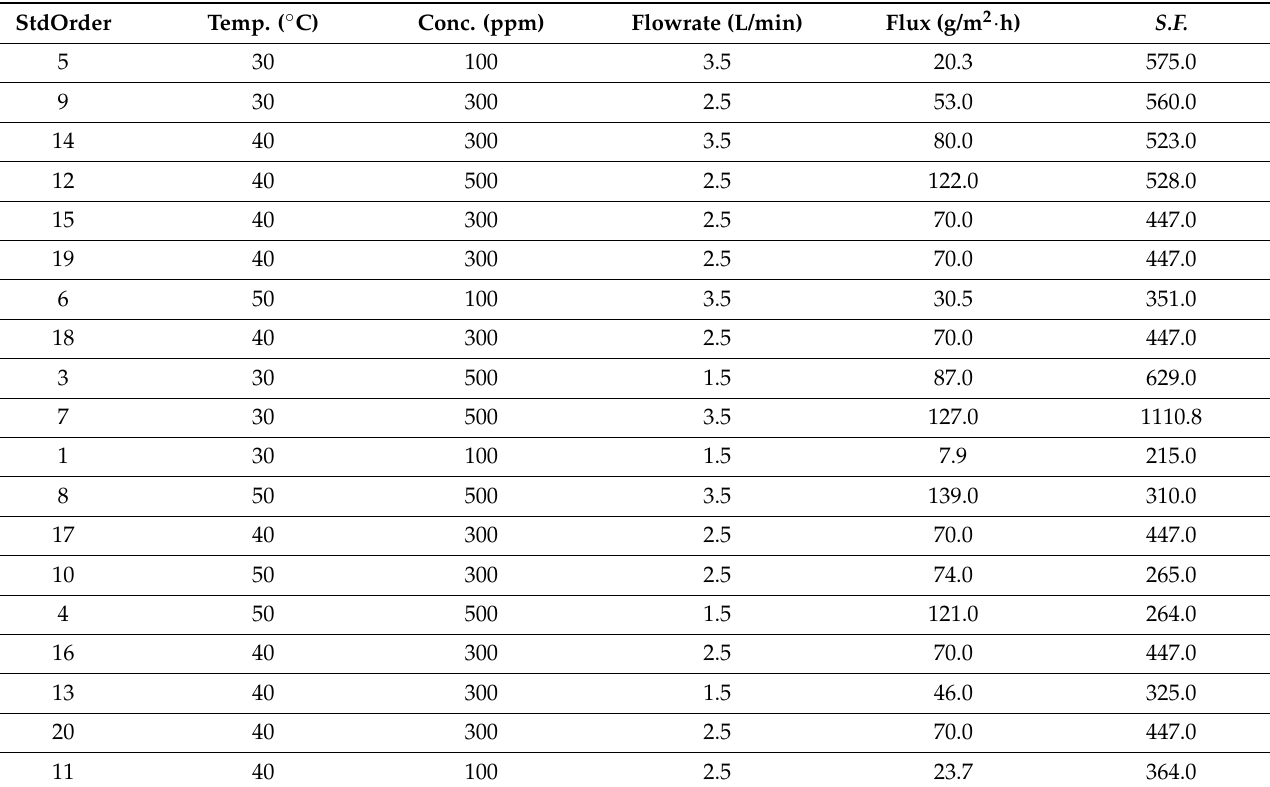
Table 1. Experimental data points and response.